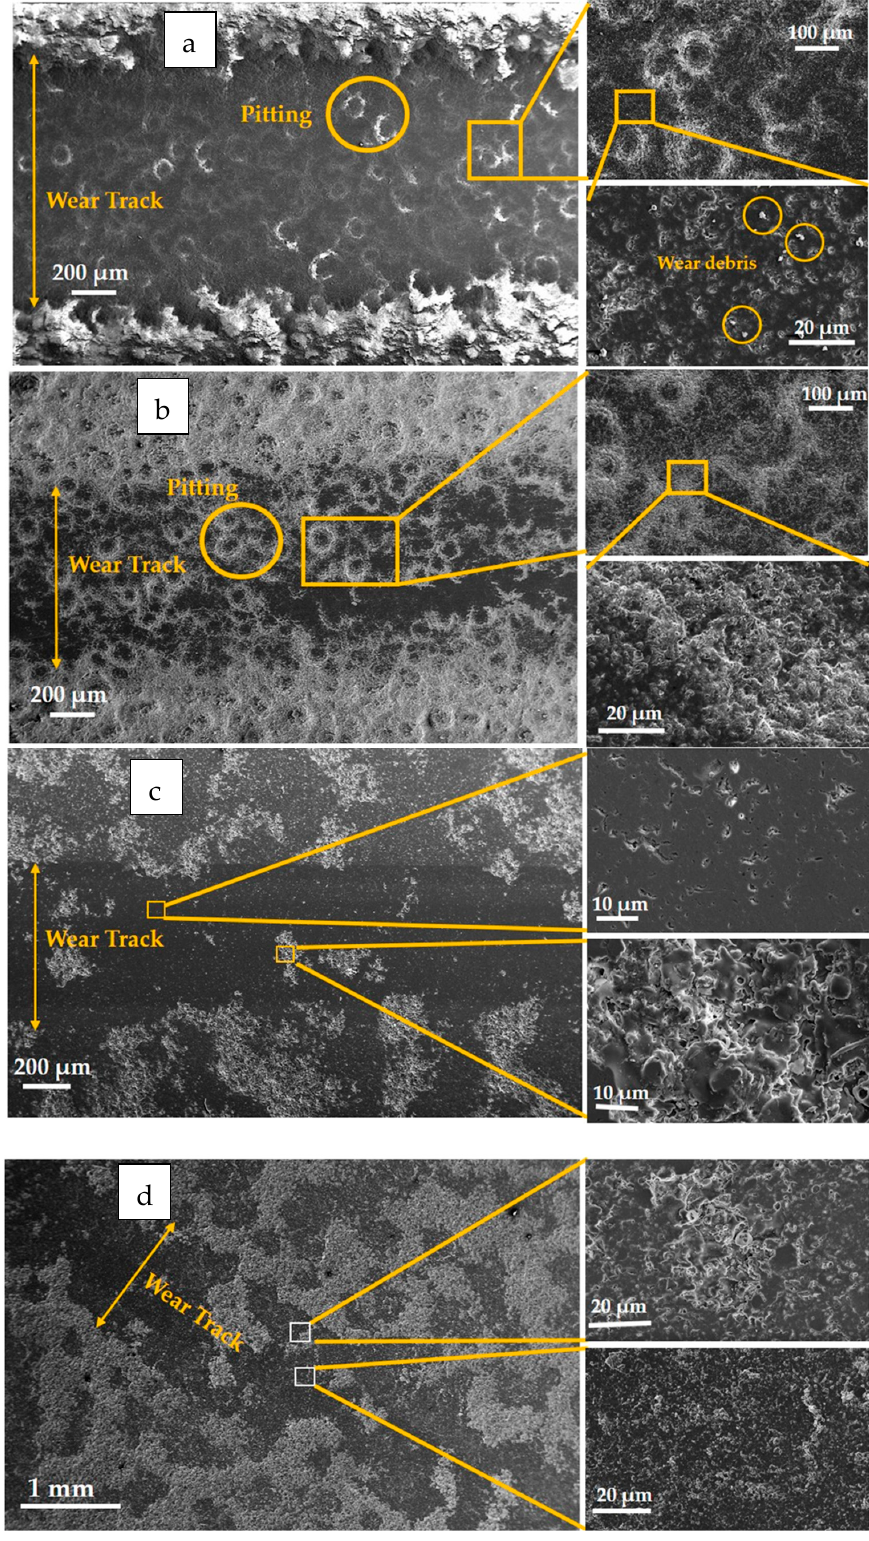
Figure 11. Worn surface morphologies at different magnifications in the case of ( a ) As, ( b ) AsYs, ( c ) Ap, and ( d ) ApYs coatings.